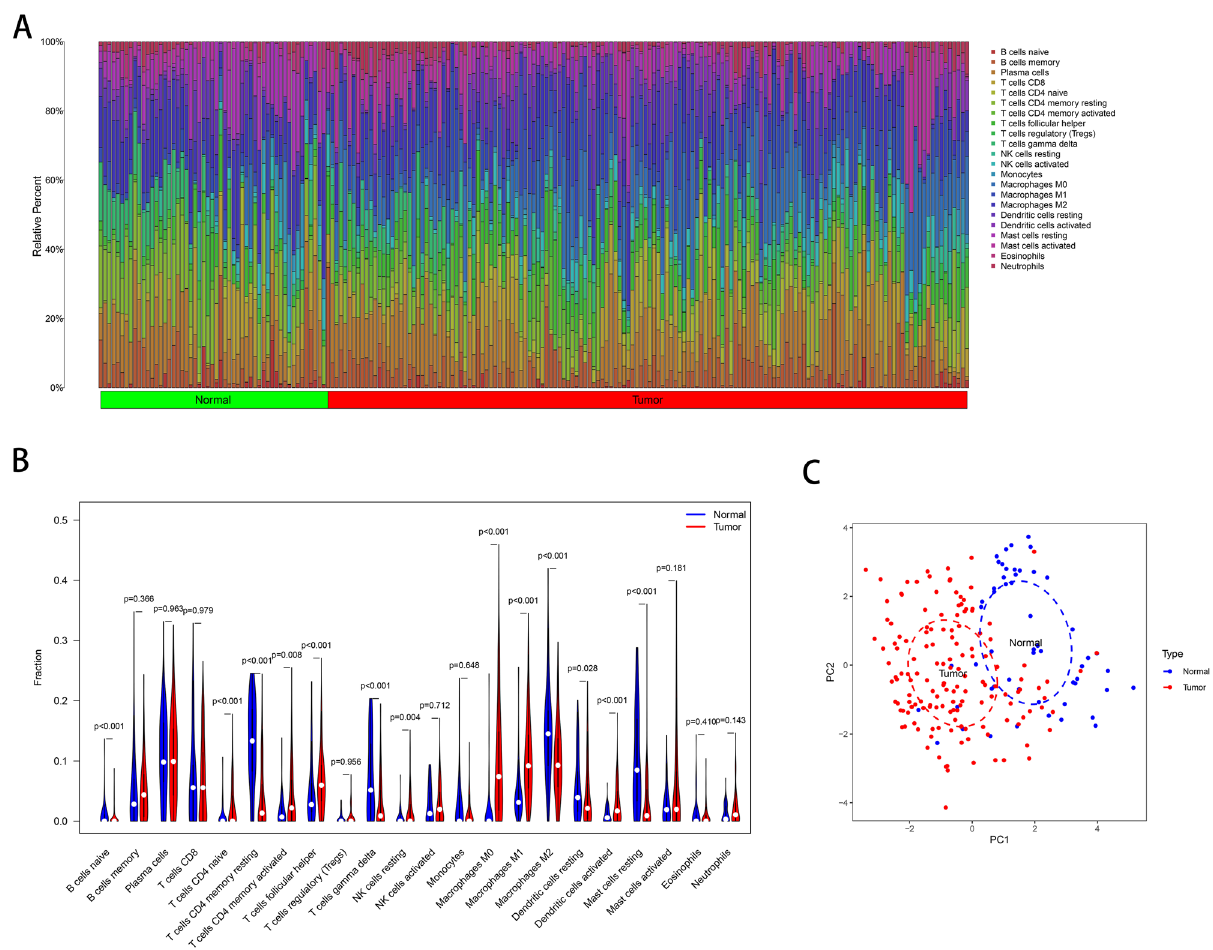
Figure 4. Characteristics of infiltrating immune cells. ( A ) Proportions of 22 immune cell subpopulations in ESCC and normal tissues. ( B ) Violin plot showing the immune cells with differential infiltration ( P < 0.05). ( C ) PCA showed that 22 types of immune cells could roughly distinguish between ESCC and normal